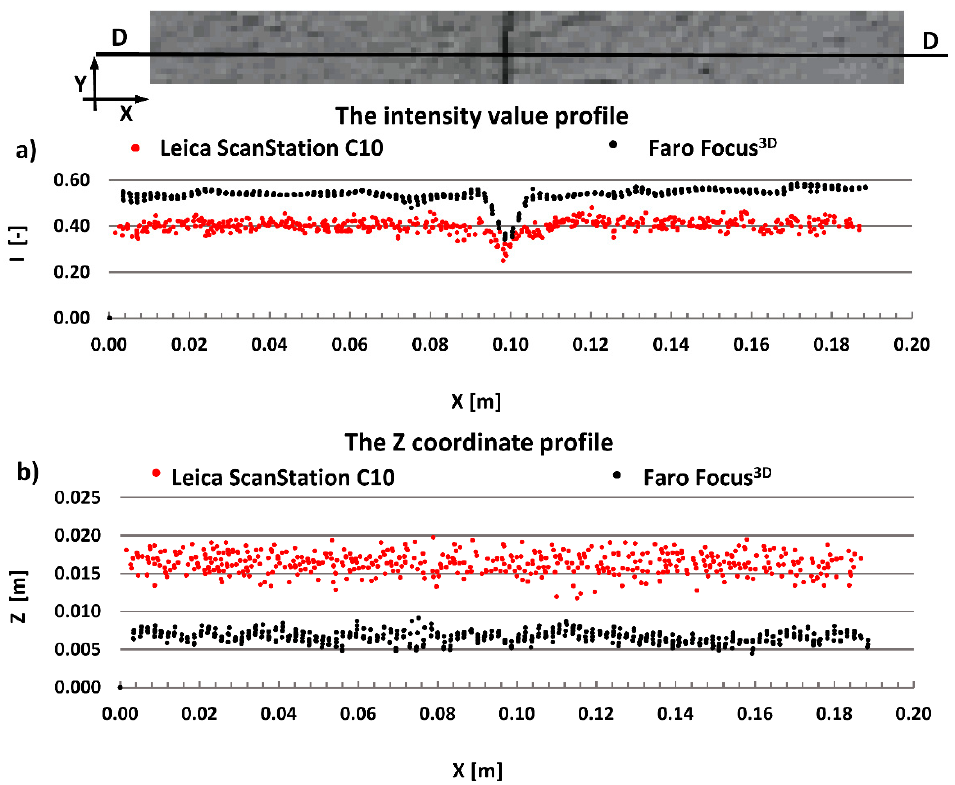
Figure 7. DD profiles—crack of wall: ( a ) intensity data profile and ( b ) geometric data profile.